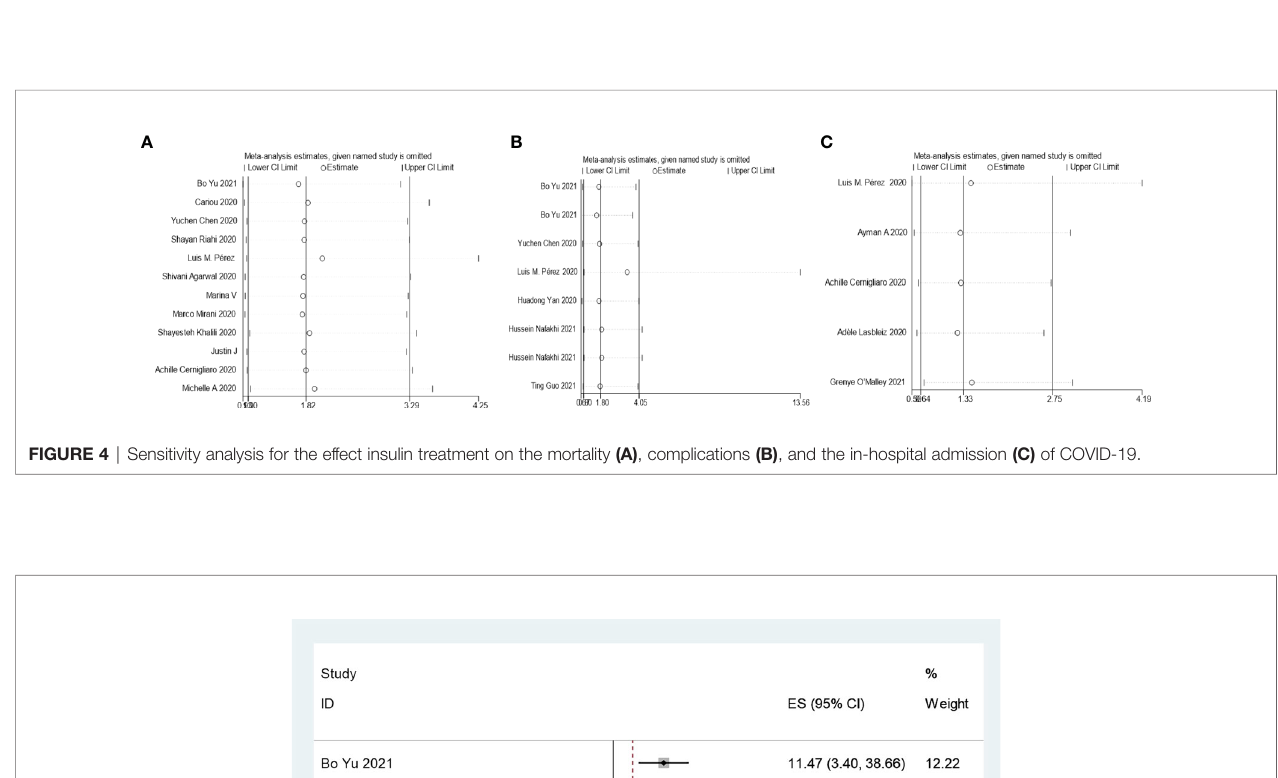
FIGURE 3 | Funnel plot of the association between the insulin treatment and the mortality (A) , complications (B) , and the in-hospital admission (C) of COVID-19.